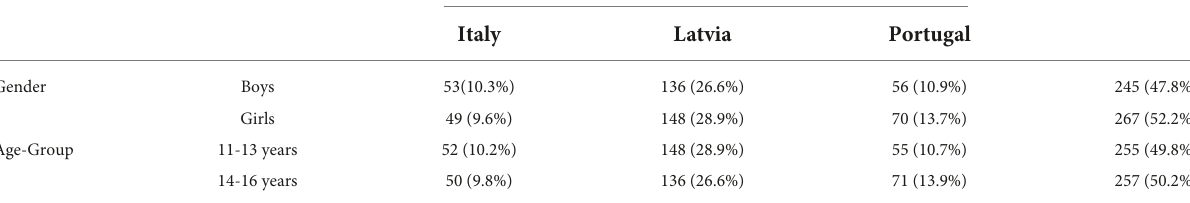
TABLE 3 Characteristics of the sample.